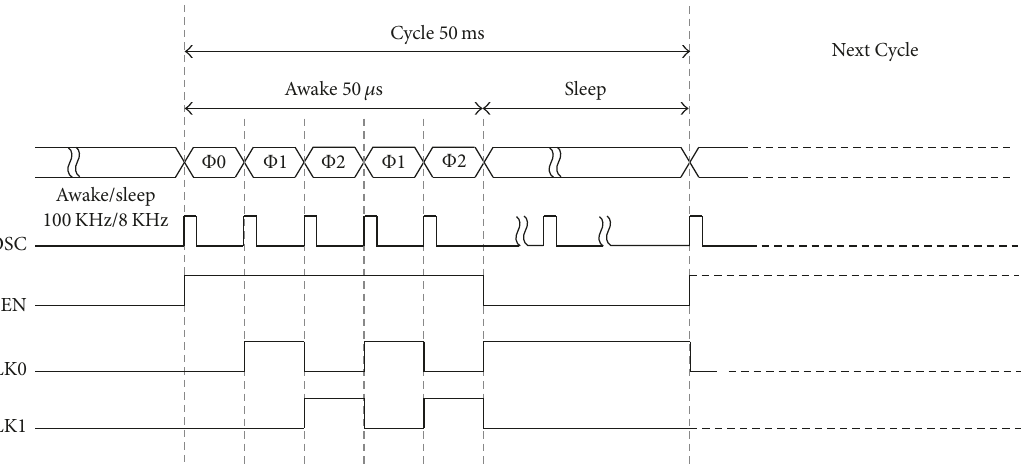
Figure 12: Circuit logic time series of the Hall switch sensor.